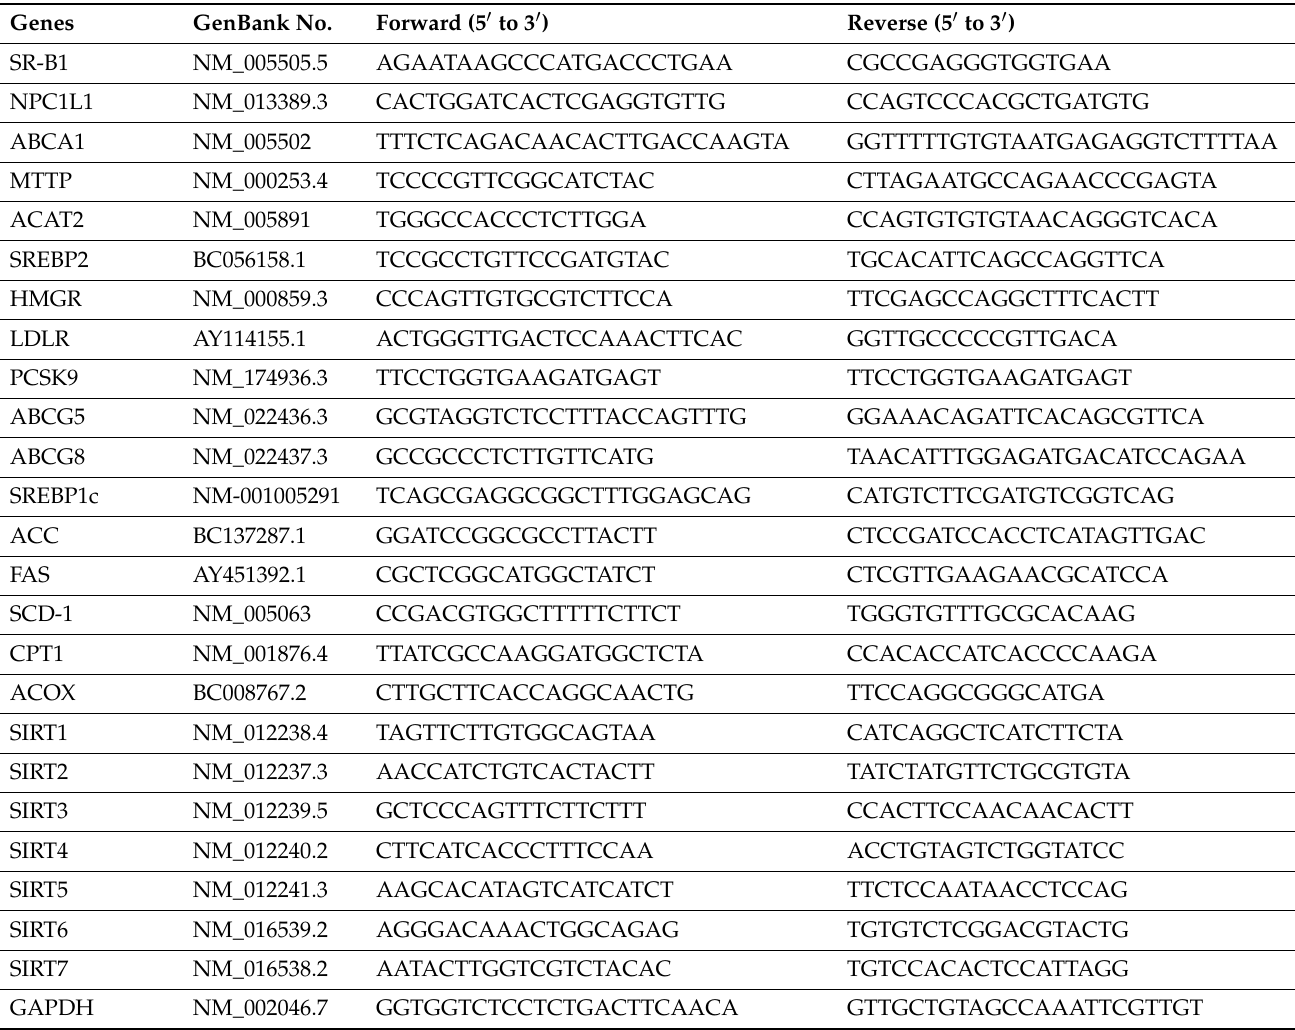
Table 1. The primer sequences for qRT-PCR analysis.